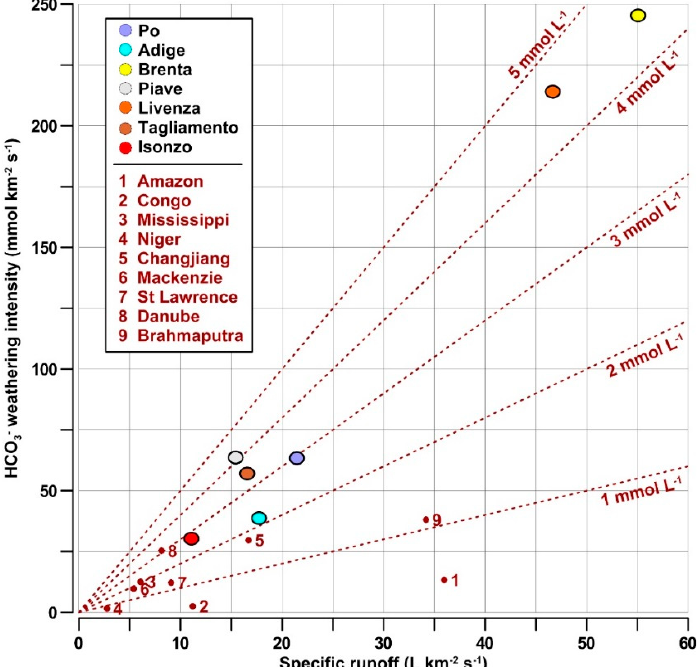
Figure 5. Weathering intensity of the HCO 3 − (mmol km − 2 s − 1 ) as a function of the specific runoff (L km − 2 s − 1 ) in each drainage basin, in comparison to the most important rivers worldwide (data from [5]).